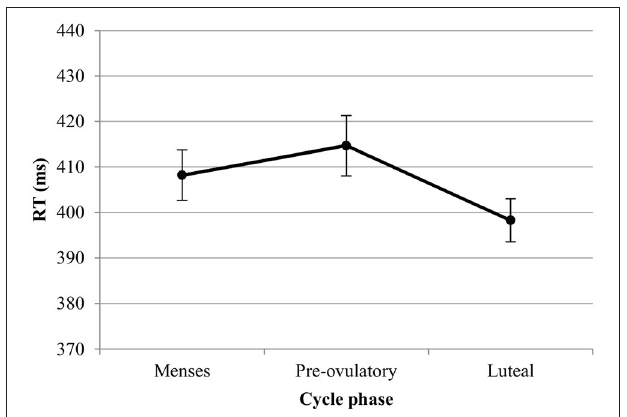
FIGURE 6 | Mean accuracy for the Stroop color along the menstrual cycle. Performance was worse in global in the luteal phase compare to menses and pre-ovulatory for women with higher EBR during menses.